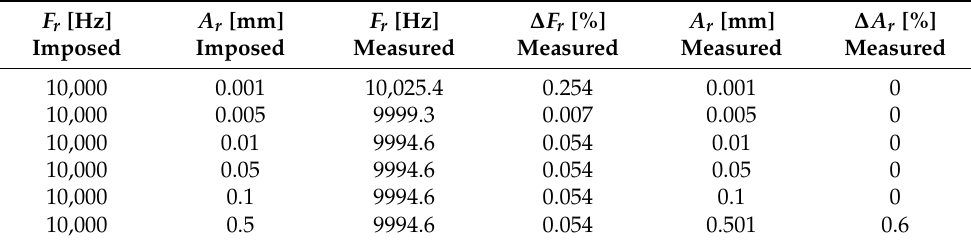
Table 2. A comparison between the imposed and measured resonance frequency ( F r ) and amplitude ( A r ) is shown. The percentage difference between the two is reported ( ∆ F r and ∆ A r ). The resonance frequency is kept constant at 10,000